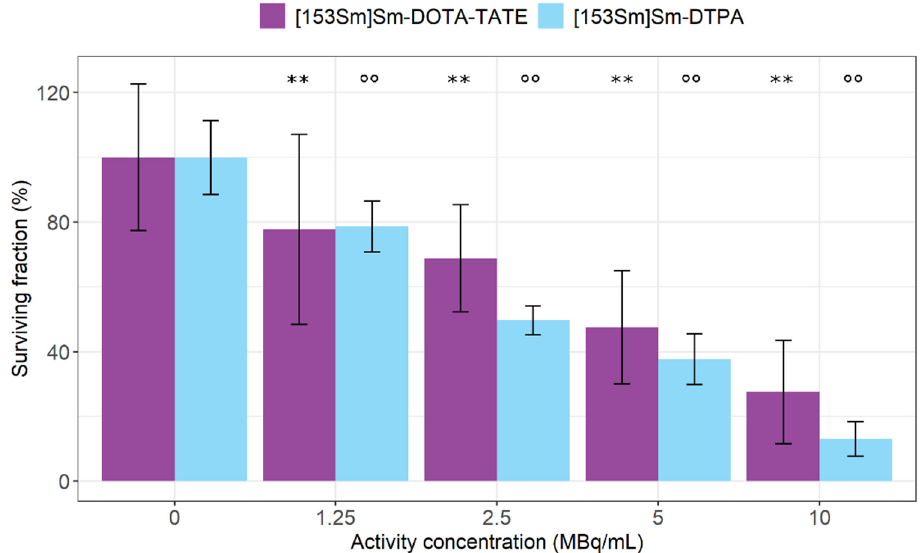
Figure 4. Surviving fraction expressed in percentages of CA20948 cells after [ 153 Sm]Sm-DOTA-TATE treatment (MBq/mL) or [ 153 Sm]Sm-DTPA treatment (MBq/mL). Values represent mean ± standard deviation. ** p < 0.01 for statistical differences relative to 0 MBq/mL [ 153 Sm]Sm-DOTA-TATE-treated cells and ◦◦ p < 0.01 for statistical differences relative to 0 MBq/mL [ 153 Sm]Sm-DTPA-treated cells, both obtained by linear modelling.